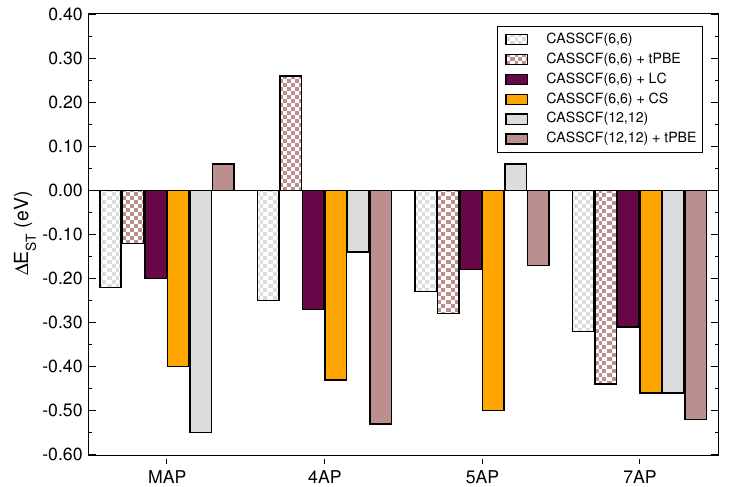
Figure 2. ∆ E ST values for the molecules selected (with the def2-SVP basis